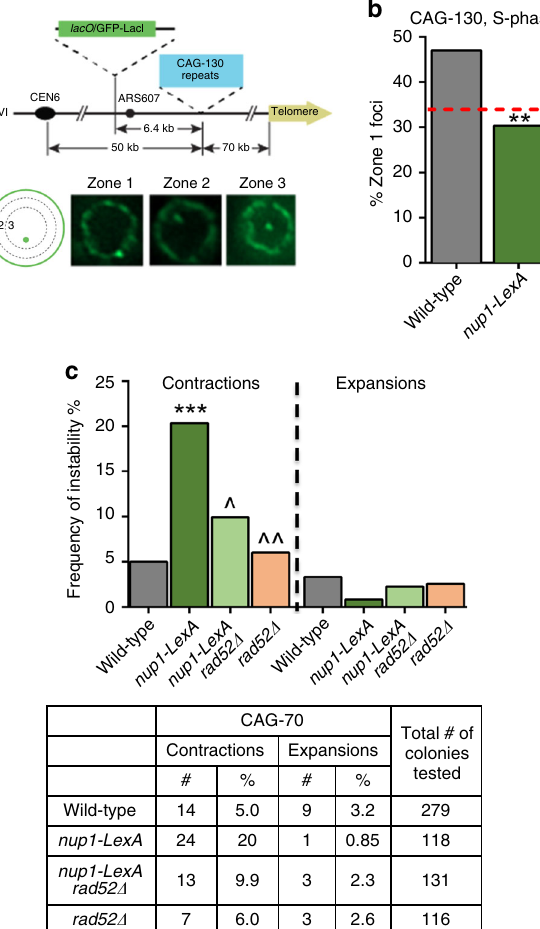
Fig. 3 Nup1-LexA affects localization and stability of CAG trinucleotide repeats. a Yeast chromosome VI containing 130 integrated CAG repeats and a lacO array that binds the LacI-GFP protein. S-phase cells were imaged, and the location of the foci was scored into one of three zones of equal area, using the GFP-Nup49 signal to mark the nuclear periphery. b Percent of zone 1 foci for CAG-130 S-phase cells (283 cells for wild-type, 142 cells for nup1-LexA ). Statistical differences were determined by a Fisher ’ s exact test (** p = 0.0012). c Frequency of contractions and expansions for CAG-70 repeats in wild-type and nup1-LexA cells. The frequency was determined by analysis of PCR amplicon length on a high- resolution fragment analyzer gel system, using PCR primers that fl ank the CAG-70 tract located on a YAC (see Fig. S6A); (***) p = 0.0001 compared with wild-type by Fisher ’ s exact test; (^) p = 0.0313; (^^) p = 0.0017 compared with nup1-LexA by Fisher ’ s exact